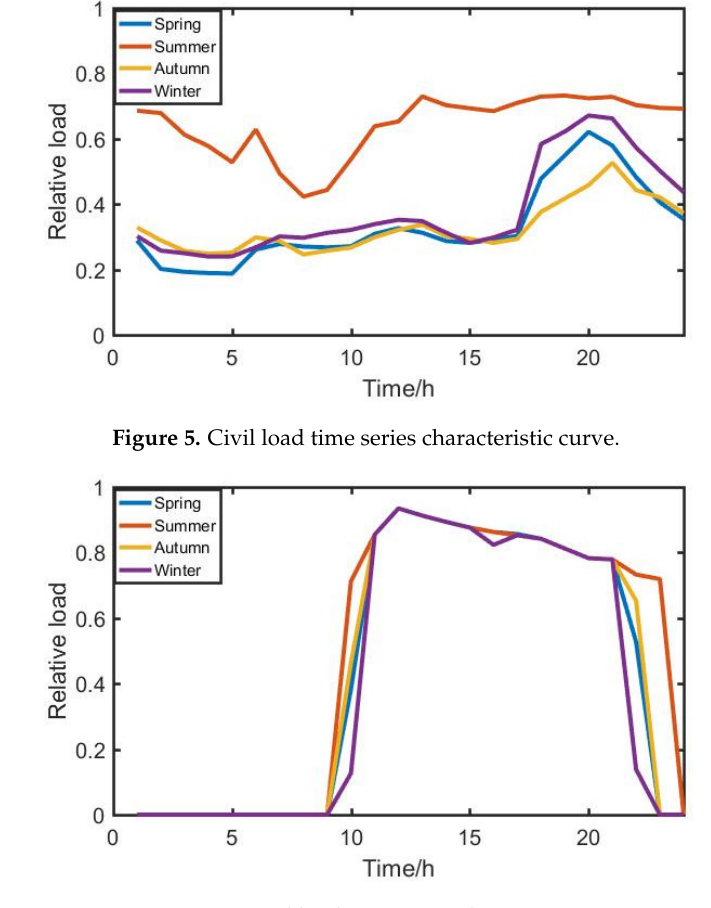
Figure 6. Commercial load time series characteristic curve.